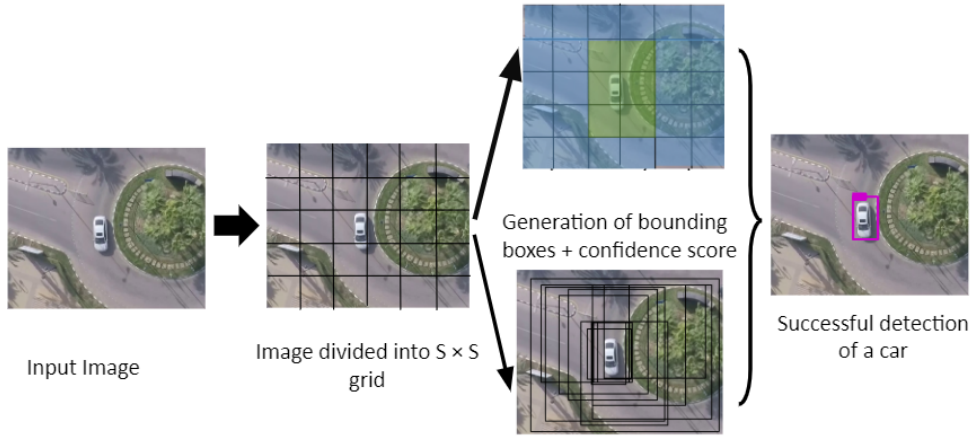
Figure 3. Successive stages of the YOLOv3 model applied on car